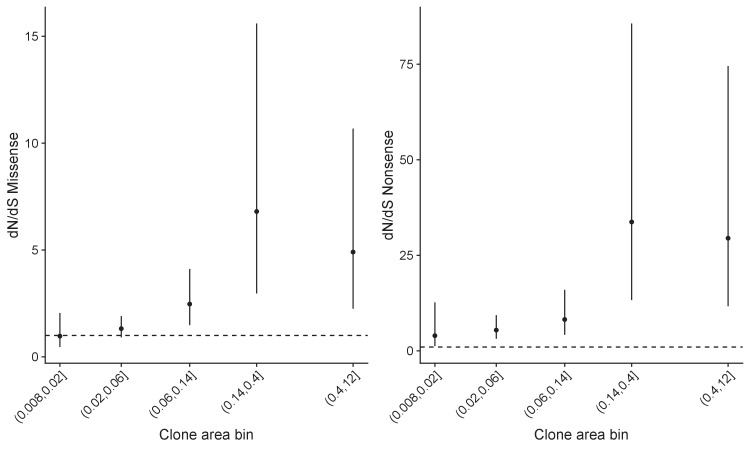
Global dN/dS values in different frequency bins for patient PD31182 showing that the values depend on the frequency of mutations.